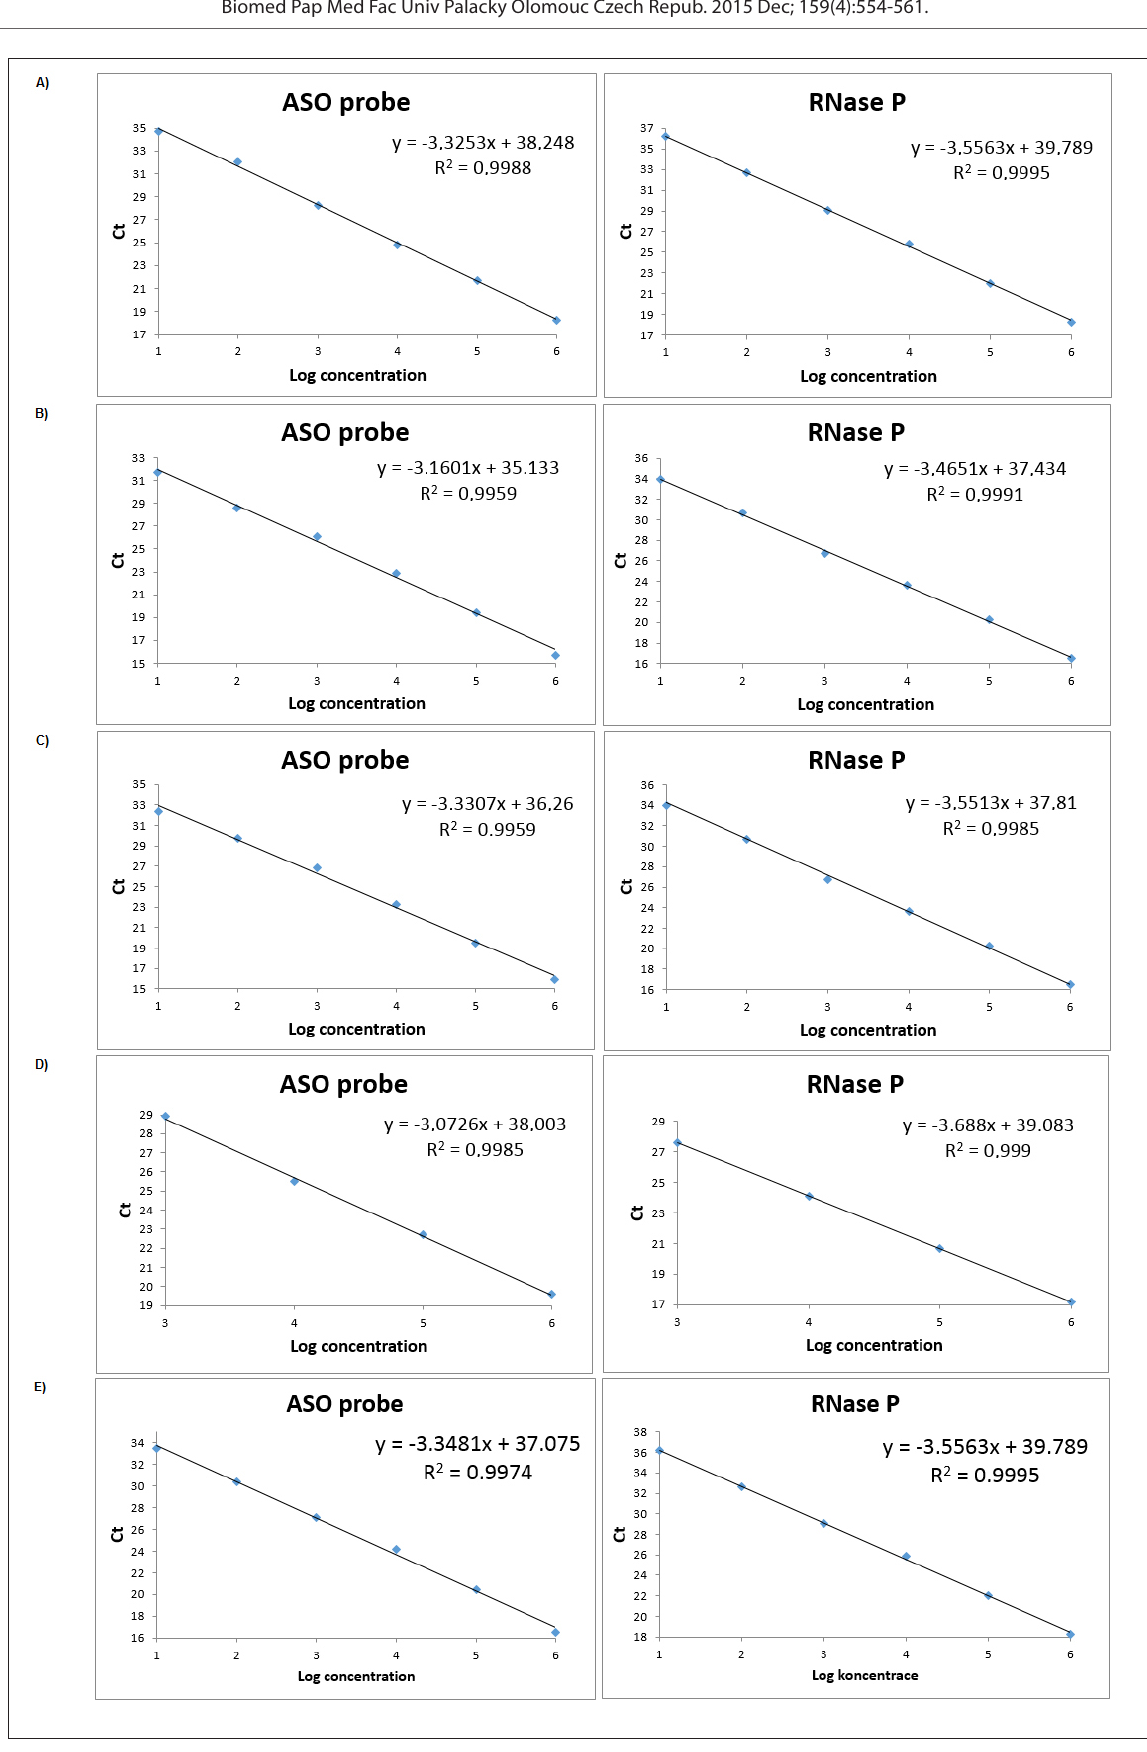
Fig. S1. Standard curves for quantitative real-time PCR detection of tumor-specific marker in